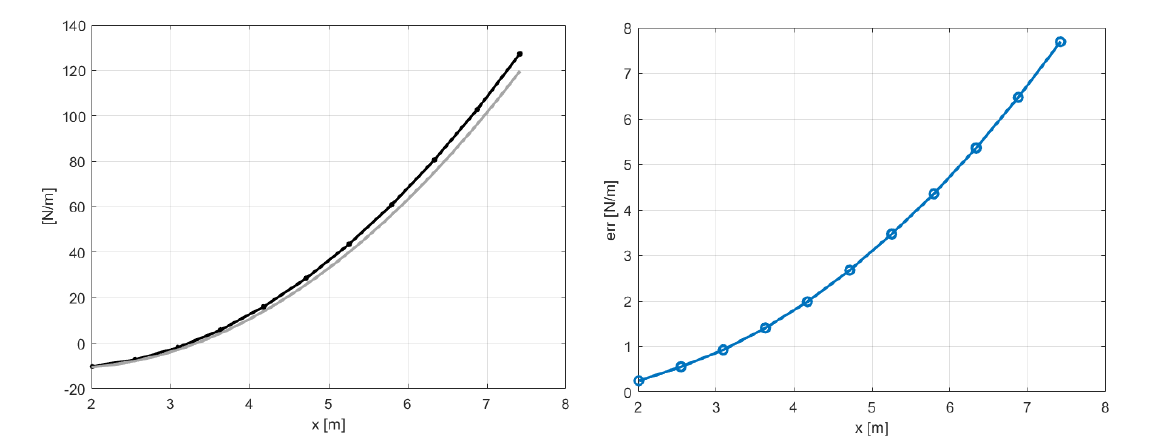
Figure 16. Distributed lift along the aerodynamic span in steady-state ( left ) and absolute error ( right ), with 11 points of integration. Reference data from